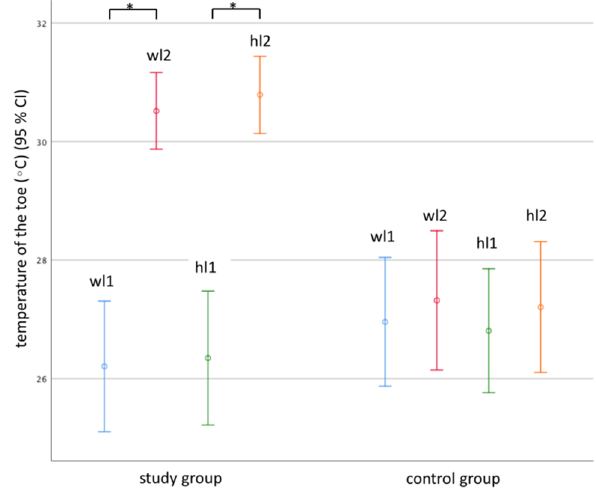
Figure 3. Temperature of the big toe before and after the treatment. Legend: wl1—leg with a wound before treatment, wl2—leg with a wound after treatment, hl1—contralateral leg without a wound before treatment, hl2—contralateral leg without a wound after treatment, * p < 0.001